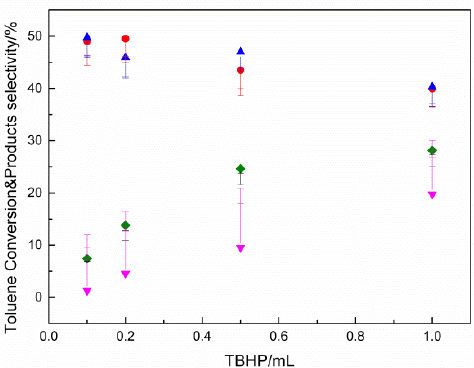
Figure 9. Catalytic performance for the selective oxidation of toluene on the Mn 3 O 4 /CNTs-3 with different TBHP.